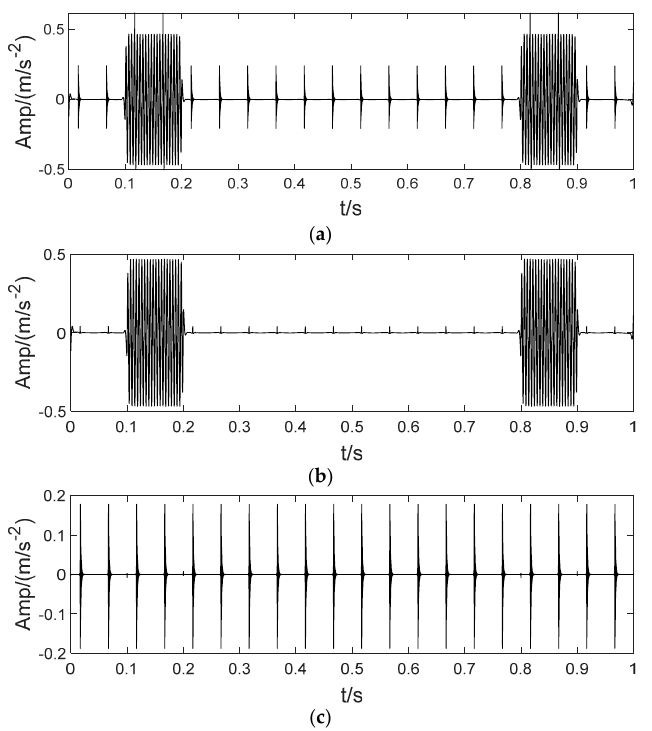
Figure 5. The second decomposition of IMF1. ( a ) The IMF1, ( b ) The IMF11 obtained by decomposition and ( c ) IMF12.